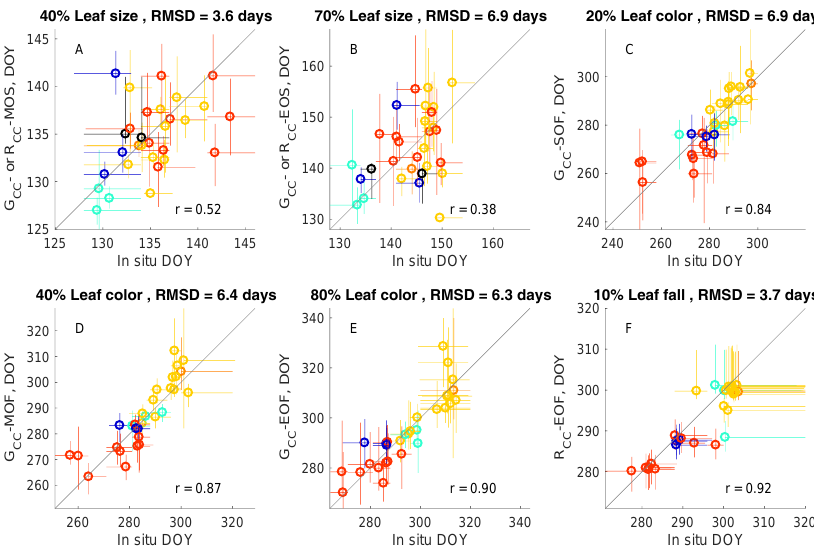
Figure 3. ( A – F ) leaf life cycle events corresponding to drone image metrics for 30 trees. Symbols denote transition dates, with confidence intervals shown as colored lines. Yellow = red oak (except trees with red spring leaves, shown in black in ( A , B )), red = red maple, light blue = American beech, dark blue = yellow birch, and orange = black oak. Deciles of in situ observations (i.e., 40% leaf size) were selected as having the minimum RMSD in comparison to drone image metrics. Jitter was added to data points that lay on the same date and the one-one line is shown in black. Correlation coefficients are shown on each panel (all p < 0.05).